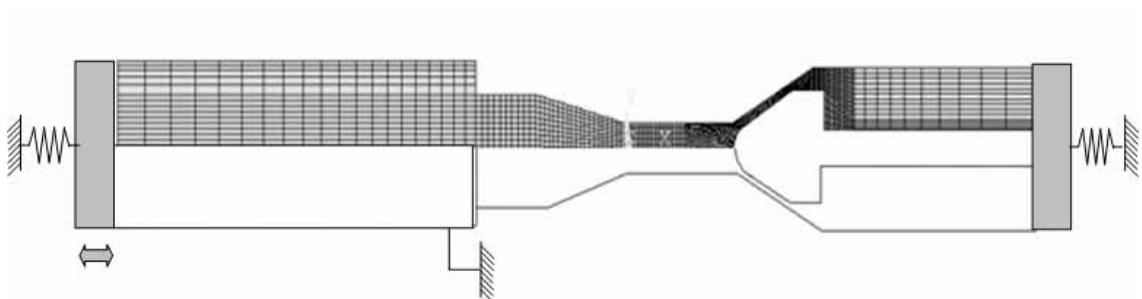
Fig. 3. Valve geometry and mesh refinement.